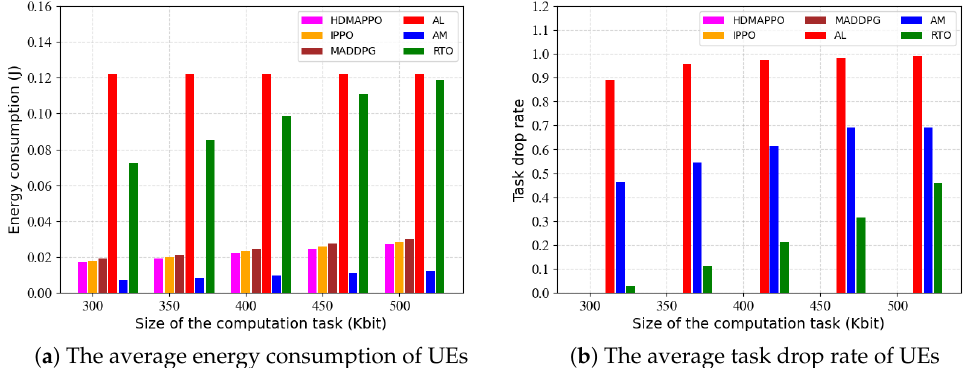
Figure 5. Impact of the data size of a task on the average latency of the task and the task dropout